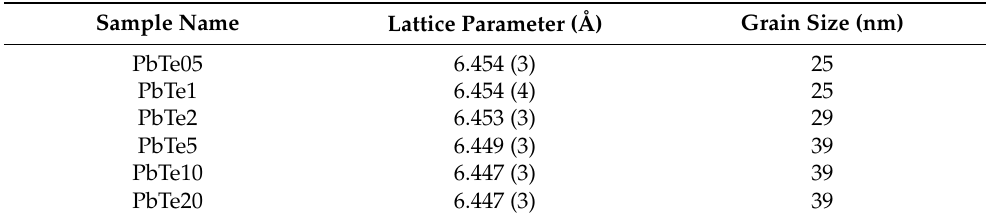
Table 3. Values of lattice parameter and grain size derived from XRD data for each sample. The parentheses number represents the measurement accuracy.